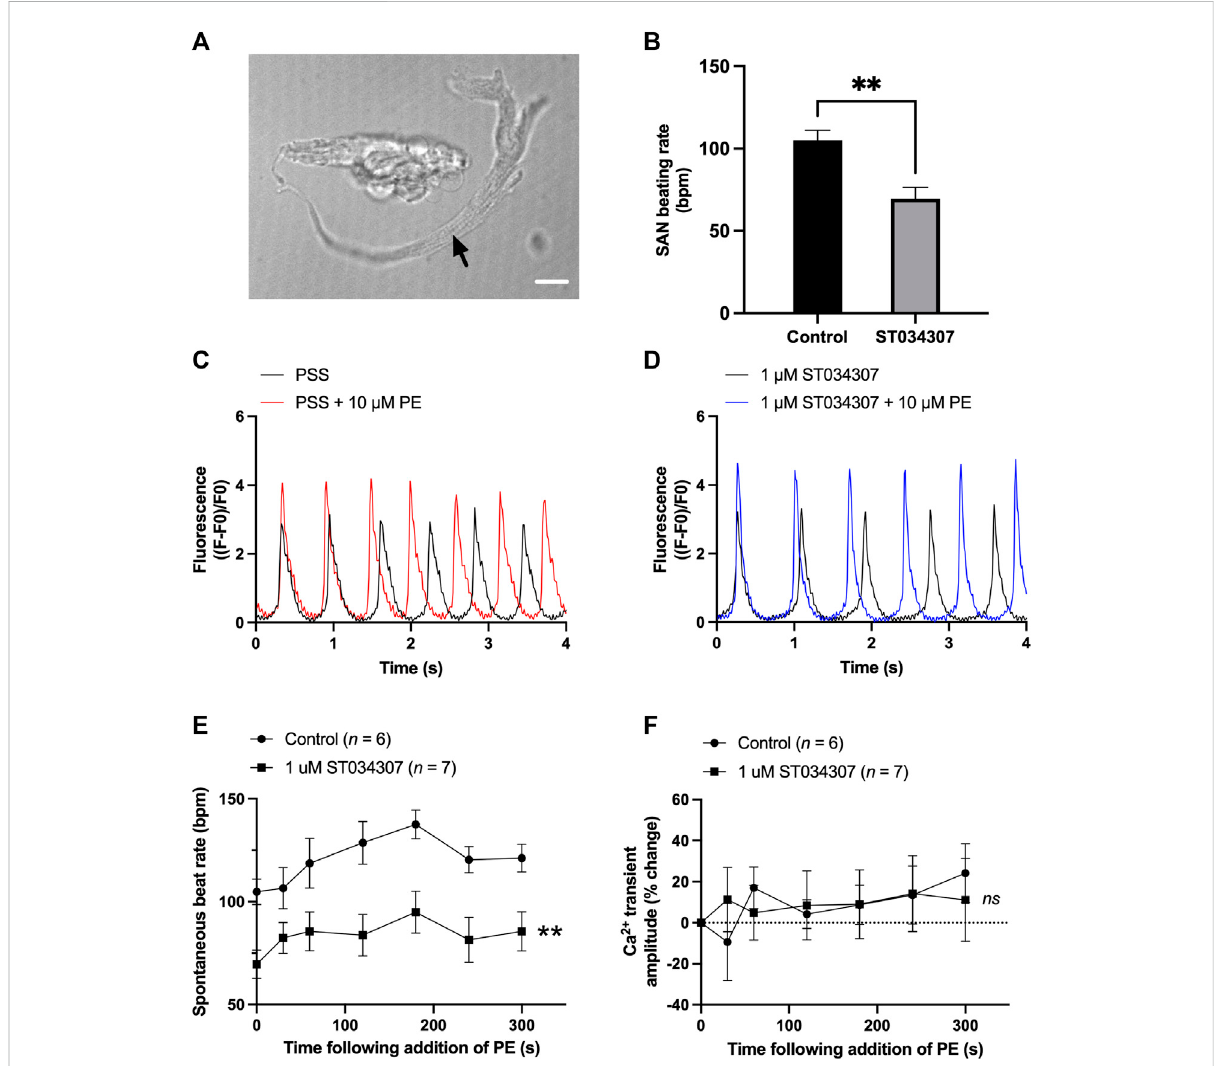
represent recordings before and 5 min after addition of 10 μ M PE, respectively. Traces have been aligned according to the peak ofthe fi rst transient. (E) Effect of 10 μ M PE on the spontaneous beating rate of isolated SAN cells in the presence (squares) and absence (circles) of 1 µM ST034307. (F) Effectof10 μ M PEontheCa 2+ transientamplituderecordedfromisolatedSANcellsinthepresence(squares)anabsence(circles)of1 µMST034307. Time in E and F represents time following addition of PE to the perfusion solution with 0s representing levels in absence of PE. All experiments were carried out at 35 ± 2 ° C. Data are represented as mean ± SEM. Data in (B) were analysed using unpaired t-test. Data in (E) were analysed using two- way, repeated measures ANOVA followed by Š ídák ’ s multiple comparisons test. Data in (F) were analysed using mixed effects analysis followed